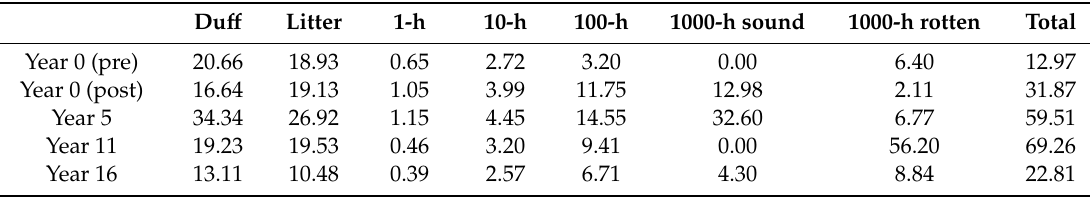
Table A1. Average fuel loading for each time point in English units (tons / acre) formatted for entry into fire